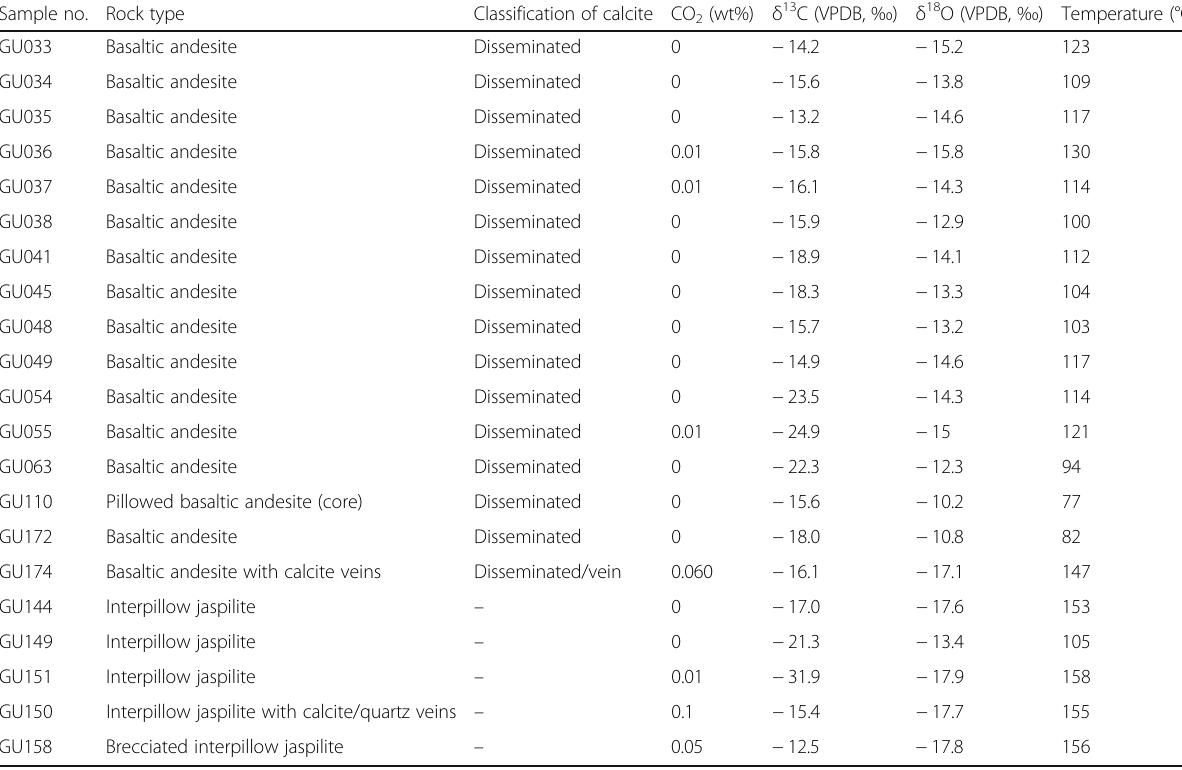
Table 1 Isotopic compositions of calcites and CO 2 content in the Ongeluk basaltic andesites and hydrothermal jaspilites Sample no. Rock type